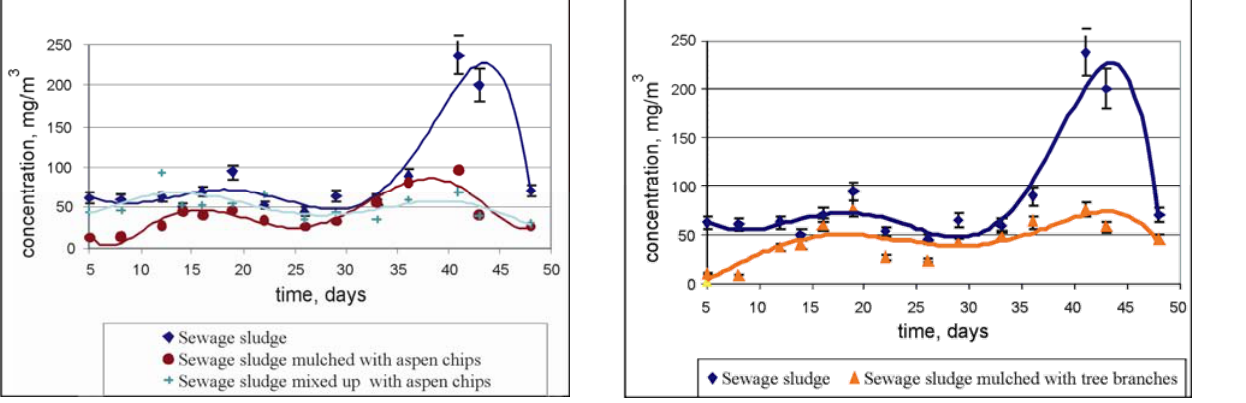
Fig. 7. Ammonia emissions during composting sewage sludge with minor